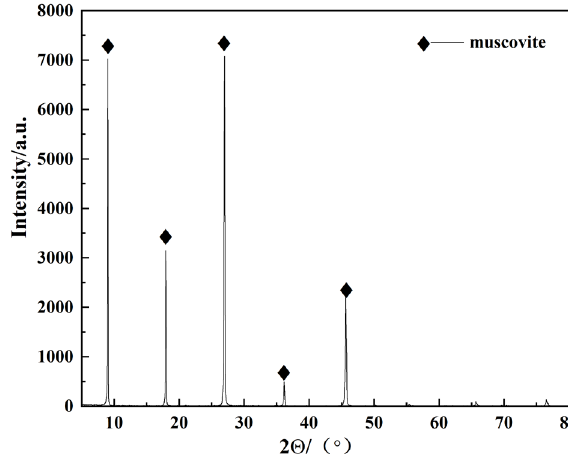
Figure 1. XRD pattern of muscovite. Table 1. Results of chemical composition analysis of Table 1. Results of chemical composition analysis of samples.